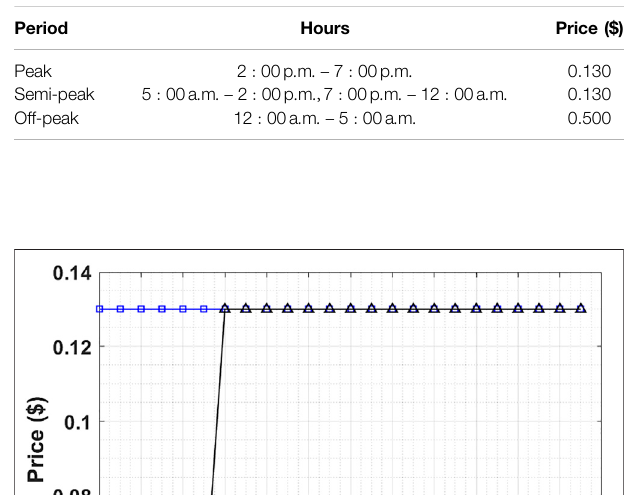
FIGURE 4 | Comparison between the actual and pre-committed load with different pricing algorithms.